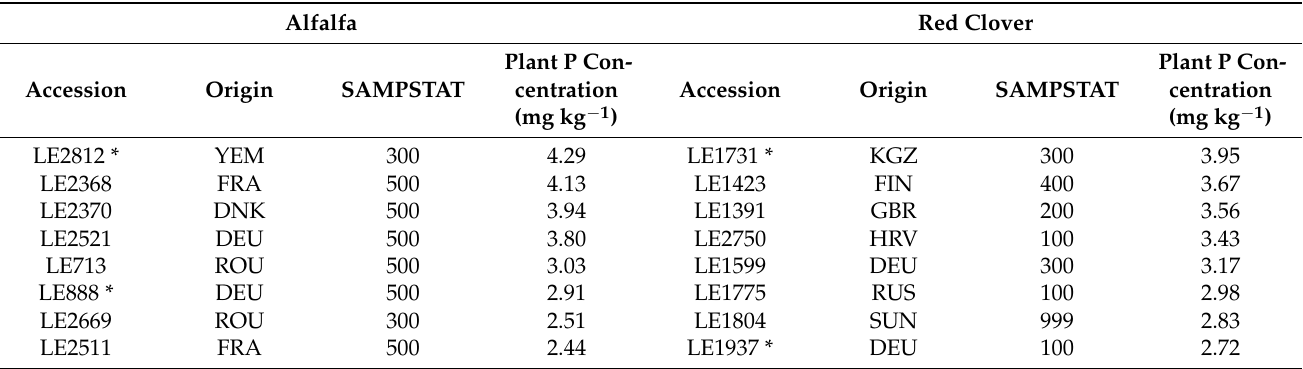
Table 1. Geographic origin, sample status (SAMPSTAT), and plant P content of selected accessions of alfalfa and red clover.